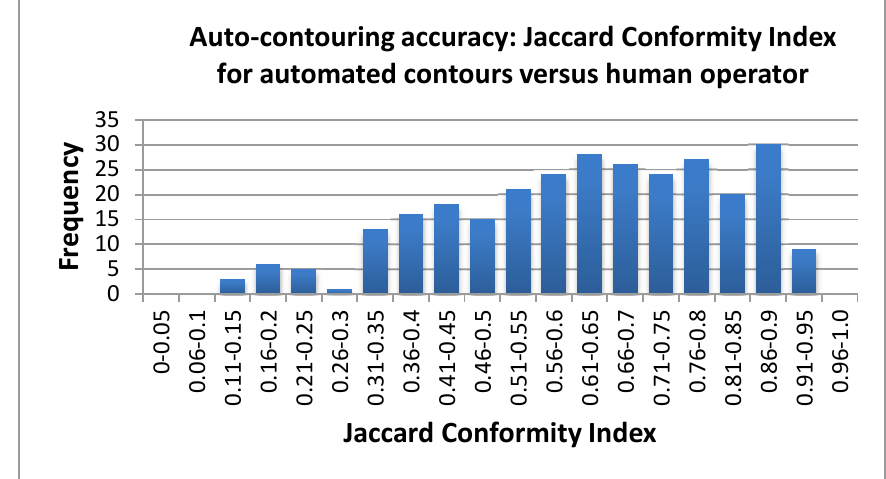
Fig. 3. Frequency distribution of JCI for 370 MV CT scans in 10 patients (~40,000 slices), compared to a single expert operator. The median JCI per scan was 0.64 (range 0.12 – 0.94).